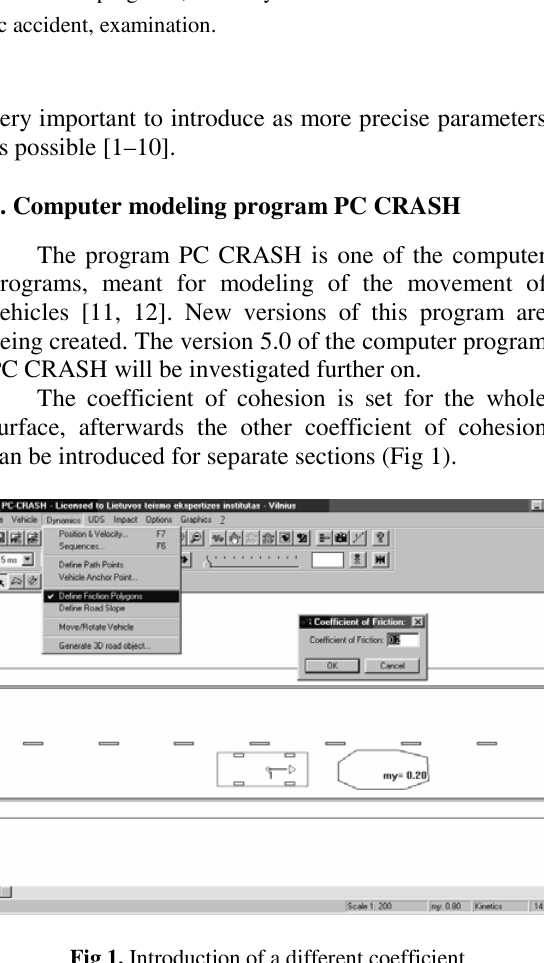
Fig 1. Introduction of a different coefficient of cohesion for a separate section of the